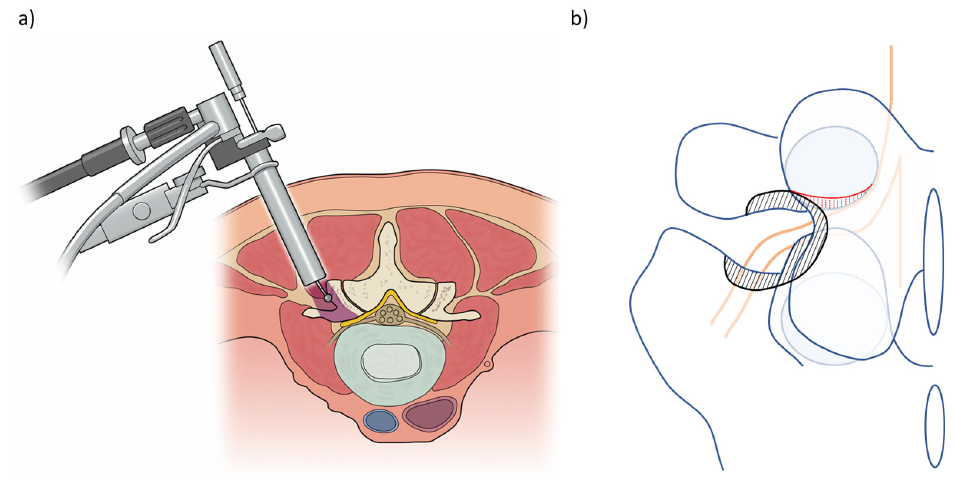
Figure 5. Schematic presentation of the ( a ) approach for foraminal stenosis and ( b ) example of the decompression area in a case of L5/S foraminal stenosis (black hatching area, bone removal area in usual decompression; red hatching area, additional pediculectomy in a case with up-down steno- sis).